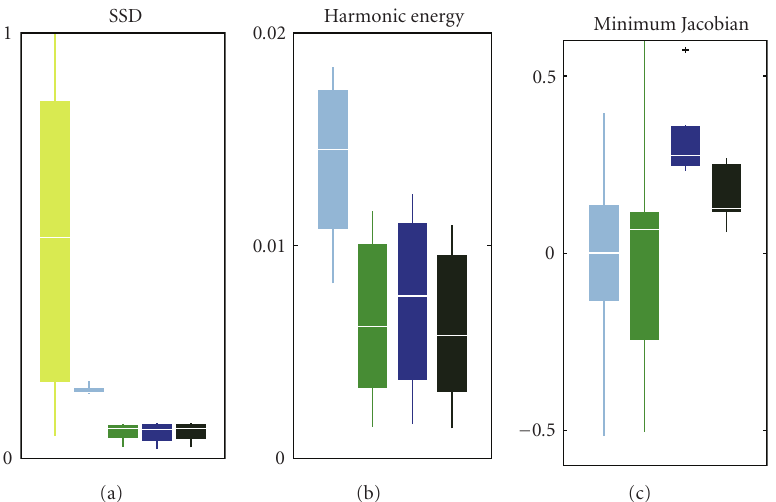
Figure 6: Results for the 9 registered phases of the POPI model. (a) Boxplots of the SSD before registration (in yellow) and after all 4 registrations. (b) Boxplots of the energy of deformationafter all 4 registrations. (c) Boxplots of the minimumJacobianafter all 4 registrations. From (a) to (c), these registrations are Demons (light blue), Morphons (light green), di ff eomorphic Demons (dark blue), and di ff eomorphic Morphons (dark green). For each box, the center horizontal line represents the median value, the box goes from the lower quartile to the upper quartile, and the vertical lines represent the most extreme values within 1.5 interquartile range. The crosses represent outlier values.